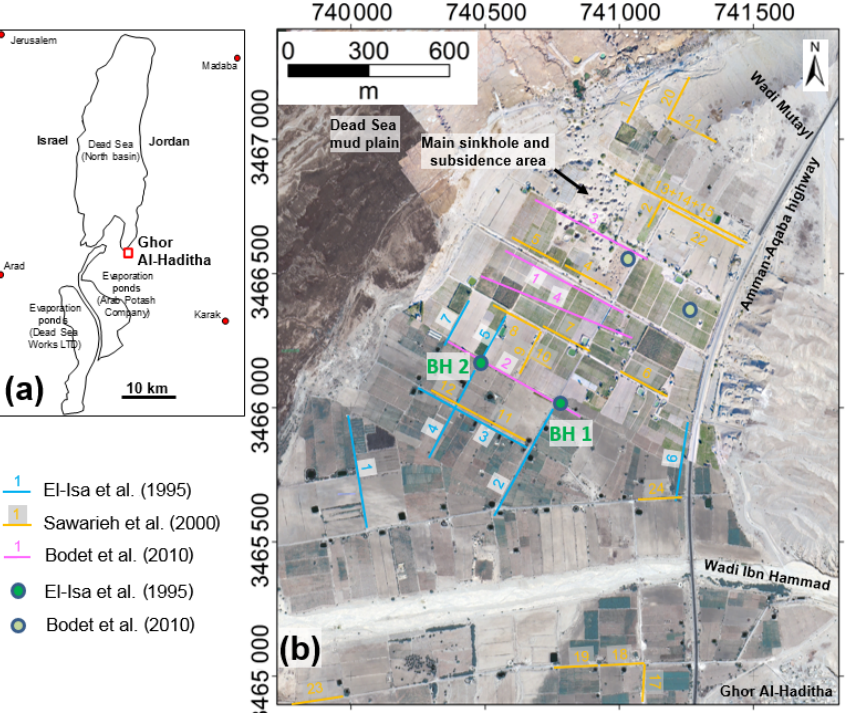
Figure 1. (a) Generalized map of the Dead Sea area. Except for the site Ghor Al-Haditha at the eastern border, which is the focus of this paper, most sinkhole sites are located along the western shoreline of the Dead Sea (see, e.g., Yechieli et al., 2002). (b) Detailed map of the Ghor Al-Haditha sinkhole site and previous refraction seismic (El-Isa et al., 1995; Sawarieh et al., 2000) and MASW (Bodet et al., 2010) profiling. Boreholes BH1 and BH2 are reported in detail by El-Isa et al. (1995); two other boreholes are reported by Bodet et al. (2010) without any further information. Background is a Pleiades satellite image from 2015 combined with an aerial orthophoto mosaic from